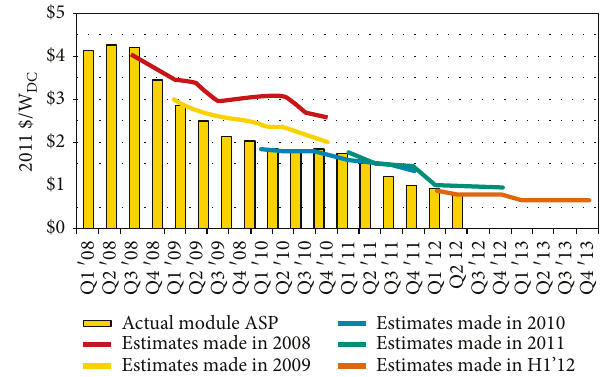
Figure 6: Approximate prices according to the average actual prices on the market analysts. Source: Department of Energy, USA,